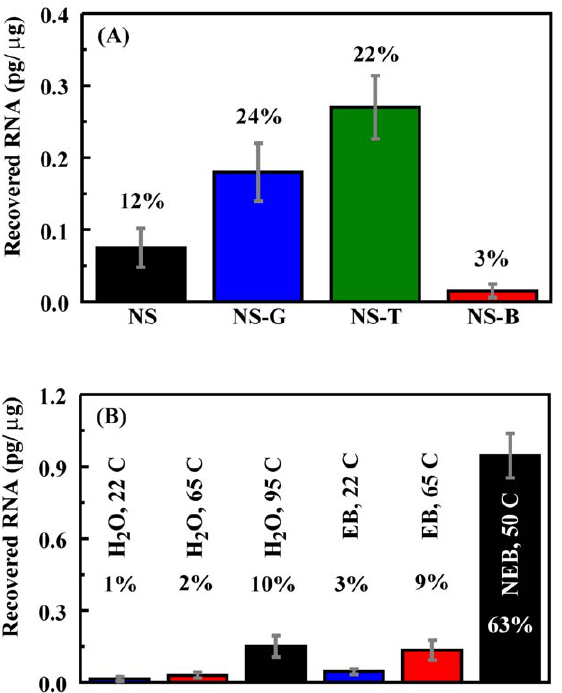
Figure 4. Recovery of RNA adsorbed by sorbents. A. Recovery of RNA from sorbents using EB buffer for elution at room temperature (22 u C). Total applied target for these studies was 1.5 pg/ m g. B. Recovery of RNA from NS-B using varied eluents at different temperatures. Values indicate the percentage of the total target bound that was recovered in the elution